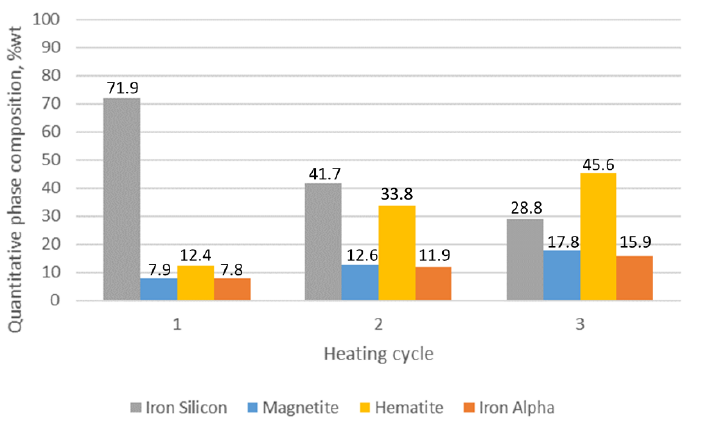
Figure 14. The quantitative share of outer oxide layer phase components for sample 1 as a function of heating cycles.